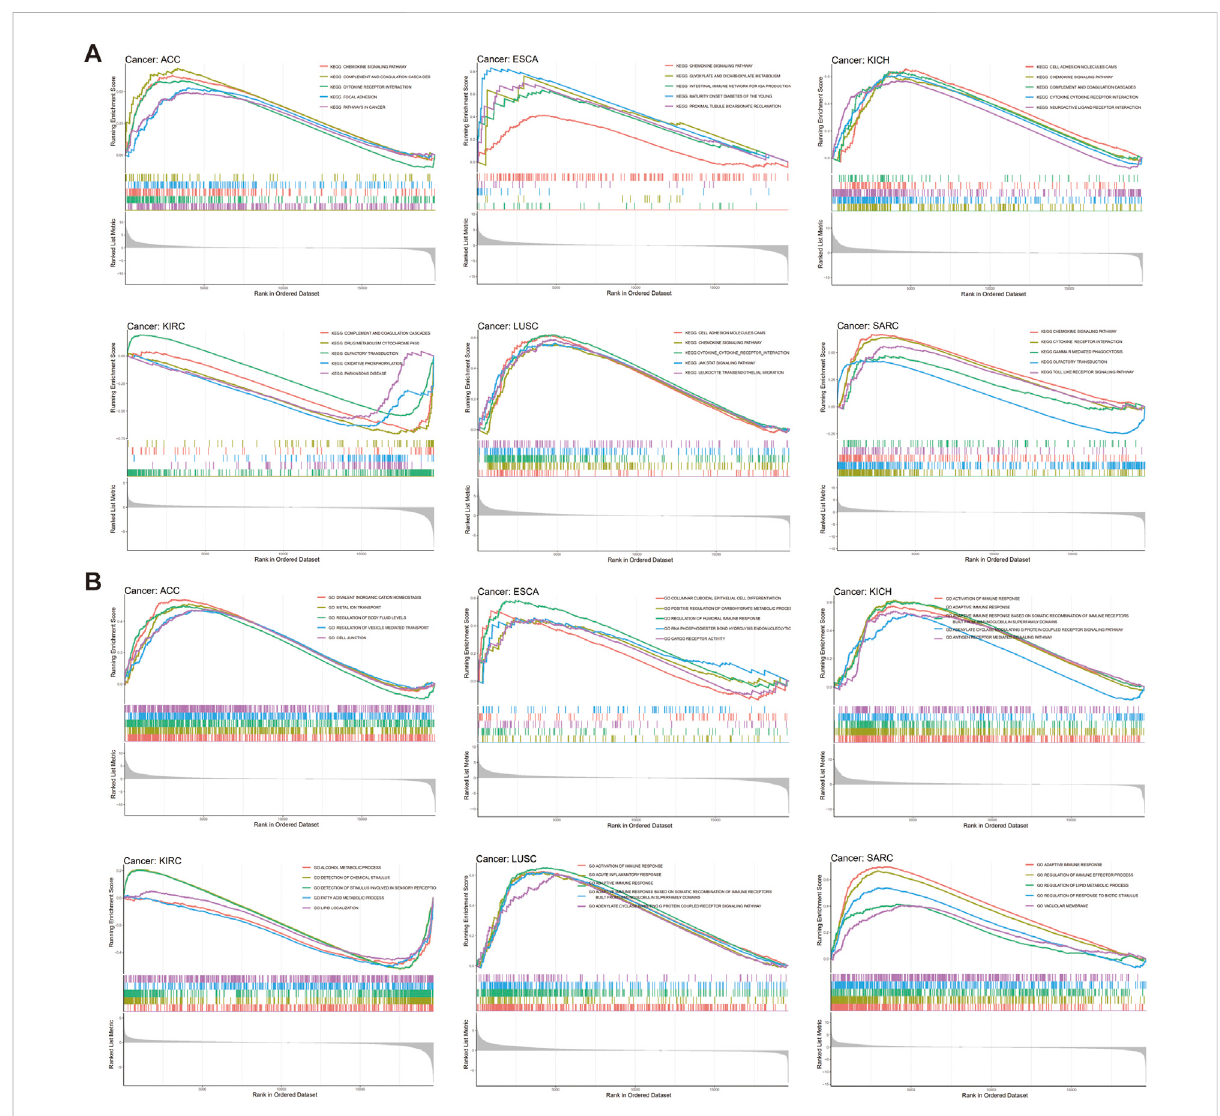
FIGURE 7 GSEA of ARRB1 expression in cancers. (A) GO enrichment plotsby the ARRB1 expression from GSEA analysis. (B) KEGG enrichment plots by the ARRB1